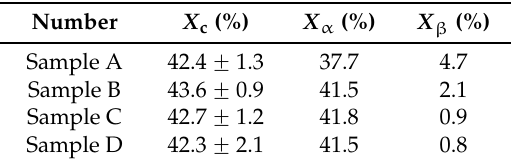
Table 2. Crystallinities and crystal structures of selected TPV samples.